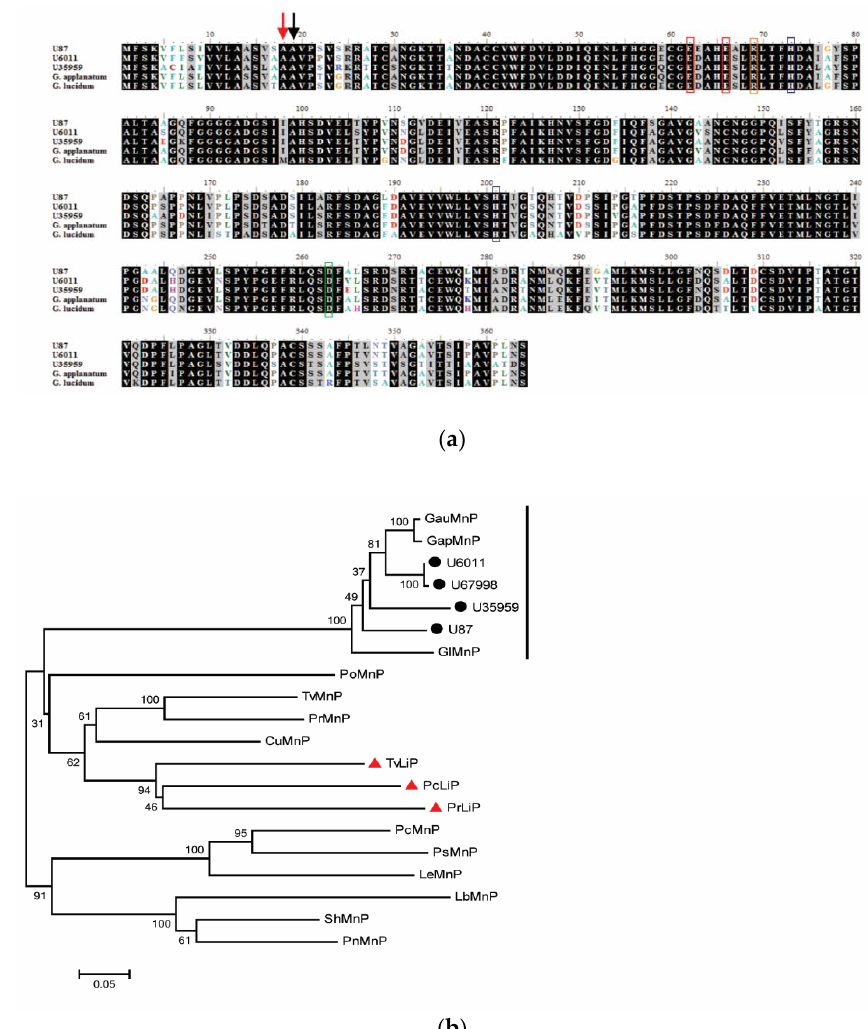
Figure 1. Sequence alignment and phylogenetic tree of GbMnPs. ( a ) Multiple sequence alignment of GbMnPs. The cleavage sites of predicted signal peptide for U87 (red), and U6011 and U35959 (black) are indicated with arrows. Distal and proximal histidine residues are indicated by blue rectangles. Red rectangles show the manganese binding sites. The orange rectangle indicates the distal arginine residue while the green rectangle indicates H-bonded aspartate residue. The conserved amino acid is shown with black background. The accession numbers for MnPs from Ganoderma applanatum (BAA88392.1) and Ganoderma lucidum (ACA48488.1) are in parentheses. ( b ) Neighbor-joining tree of deduced amino acid sequences of MnP from G. boninense PER 71 and other fungal MnPs. Numbers at the branches show bootstrap support of 1000 replicates. The tree is drawn to scale, with branch lengths having the same units to evolutionary distance denoted by the horizontal bar (0.05 amino acid substitution per site). MnP sequences obtained from this study are labeled with black circles and LiP sequences retrieved from NCBI are labeled by red triangles. Abbreviations of MnPs from: Cerrena unicolor (CuMnP, AGS19355.1); Dichomitus squalens LYAD-421 SS1